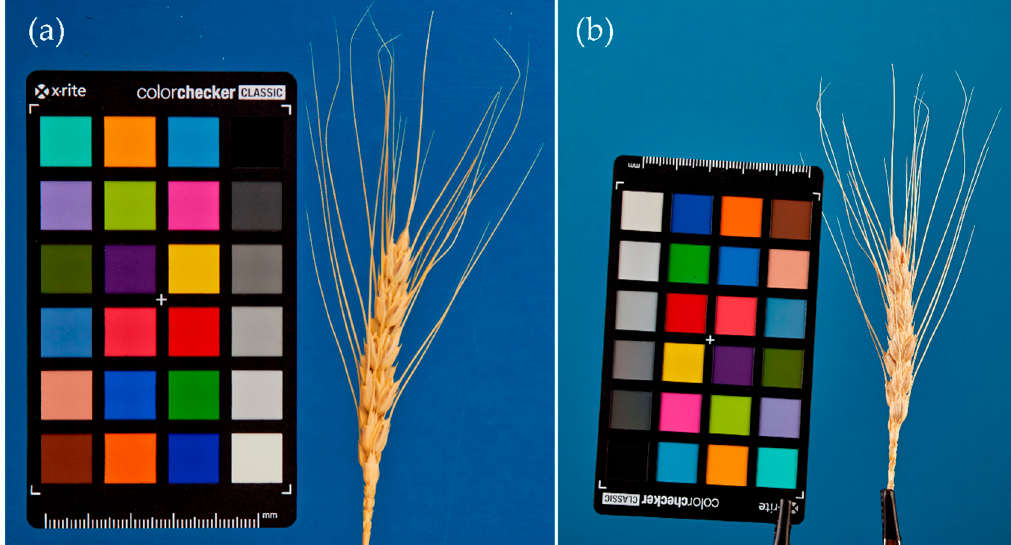
Figure 1. Images of spikes captured by two di ff erent protocols: ( a ) On a table and ( b ) fixed with a clip holder.